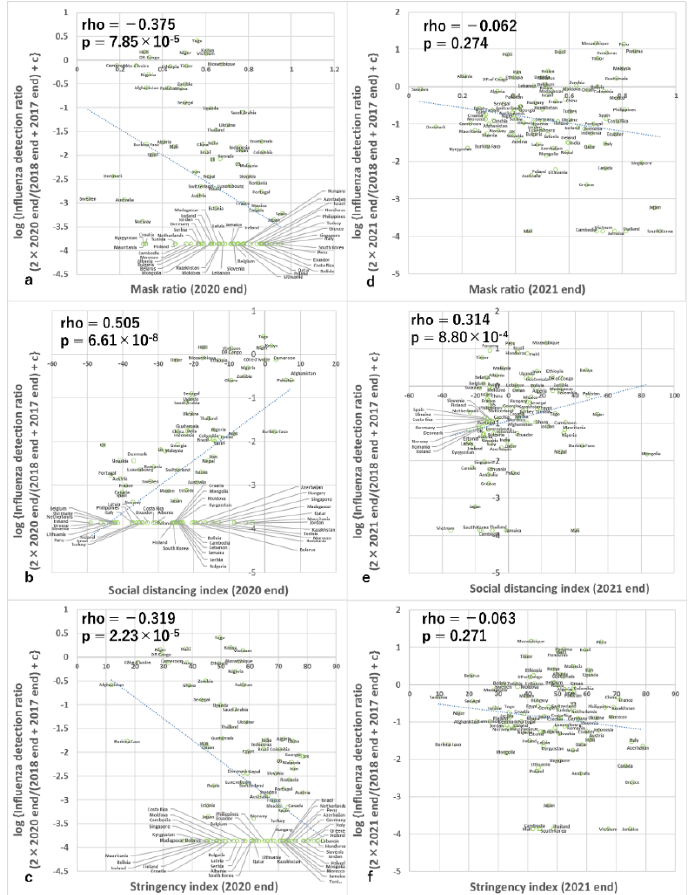
Figure 2. Association between infection control measures and influenza reduction in the end-seasons. Association between influenza detection rate and ( a ) mask use in 2020, ( b ) social distancing index in 2020, ( c ) stringency index in 2020, ( d ) mask use in 2021, ( e ) social distancing index in 2021, and ( f ) stringency index in 2021. c in the y-axis is 0.0137. The p -value is Spearman’s simple correlation test with a one-tailed test. Rho is the correlation coefficient of non-parametric correlation analyses. Note the many data points of the lowest value of the y-axis in all the panels correspond to no detection of influenza during the period according to the conversion equation.